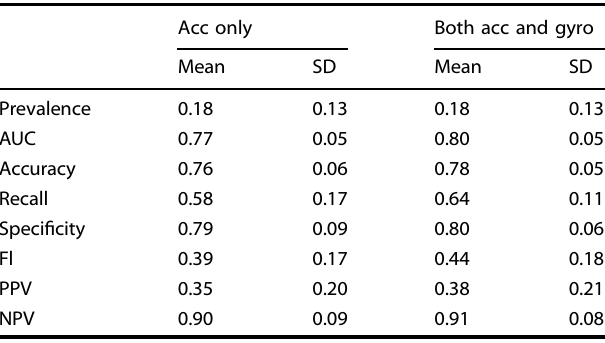
Table 3. Leave-one-subject-out evaluation of scratch binary classi fi er.